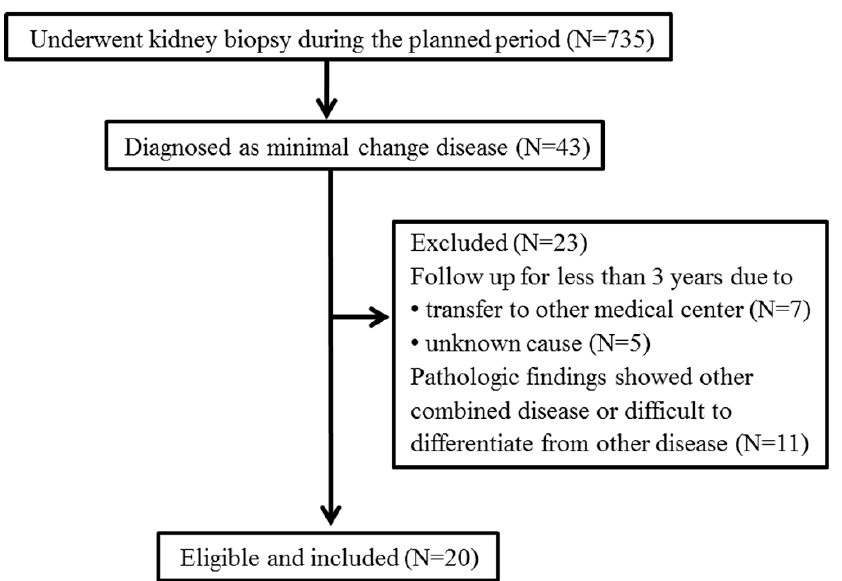
Figure 1. Retrospective study population.